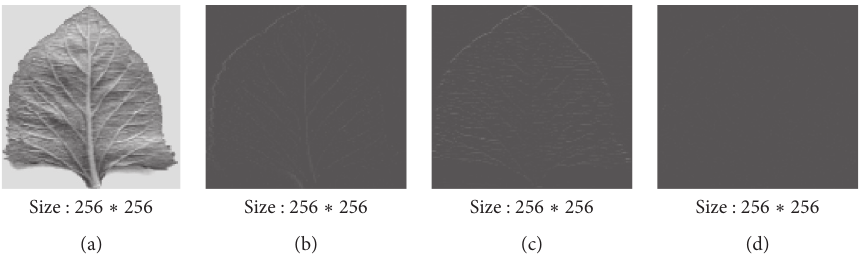
1 ; (b) vertical detail V 1 ; (c) horizontal detail H 1 ;